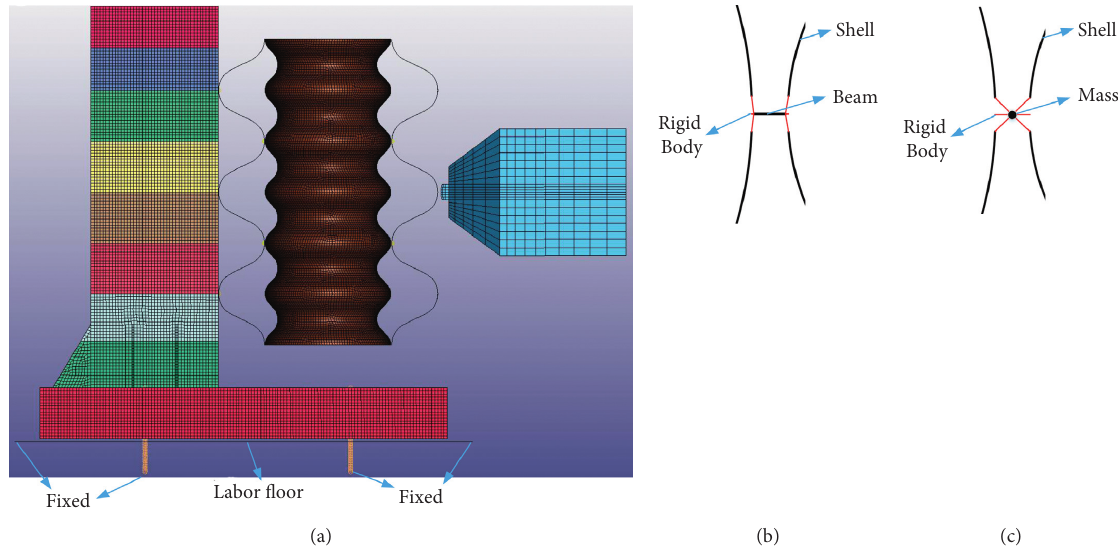
Figure 5: Simplified finite element model of the impact test: (a) finite element model of the impact test; (b) the bolt is simplified to Beam+rigid body; and (c) the bolt is simplified to mass+rigid body.